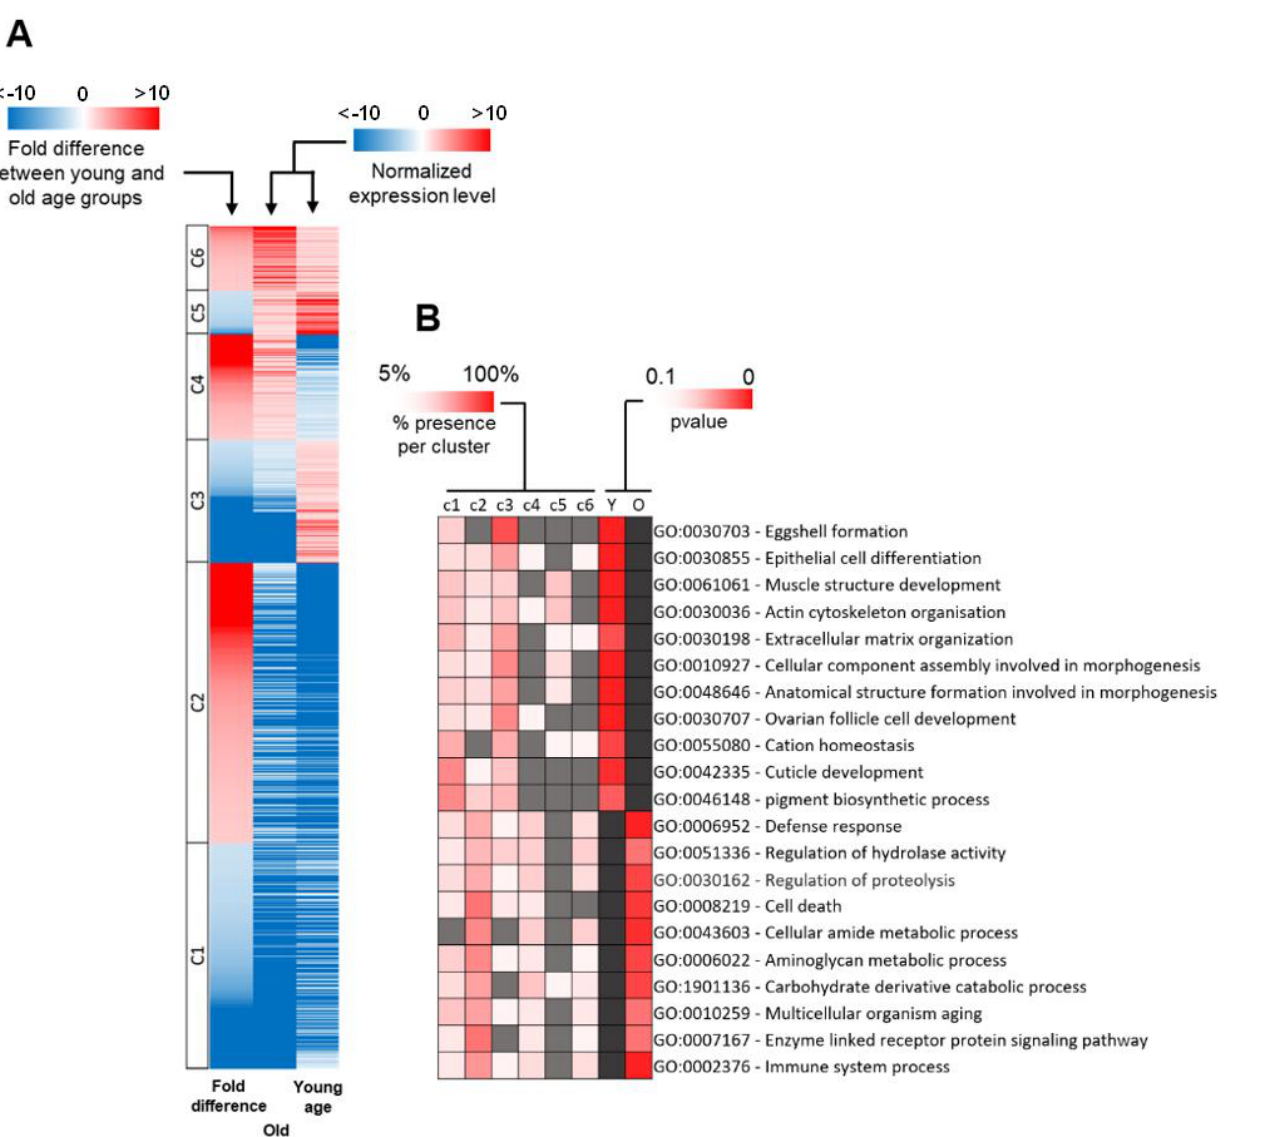
Figure 3. Functional classification of differentially expressed genes between young and old age groups. ( A ) Heatmap of differentially expressed genes. Expression values for the old and young age groups are shown as normalized to the mean of the expression of all genes. Blue color indicates that the expression level of a gene is lower than the mean, whereas a red color indicates a higher expression level. The fold difference column corresponds to the difference of expression of a gene between old and young age groups. The blue color corresponds to a downregulated gene in the old age group, whereas the red color corresponds to an upregulated gene in the old age group. The six gene classes are shown. ( B ) GO-term function enrichment analysis of old and young age groups and the prevalence of each GO-term in each gene class. The first six columns correspond to the six classes represented in Figure 3A (c1 to c6). The significance of the most represented GO-term in the old and young age groups is indicated by the p -value in the last two columns (Y for the young age group and O for the old age group). The heatmap below each gene class corresponds to the percentage of genes belonging to each GO-term that are present in this gene class. A grey tile means that less than 5% of the DEGs that belong to this GO-term are members of this gene class. A dark grey tile means that this GO-term is not overrepresented in this